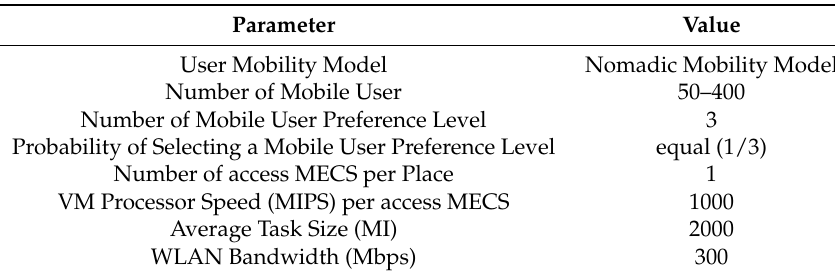
Table 1. Simulation